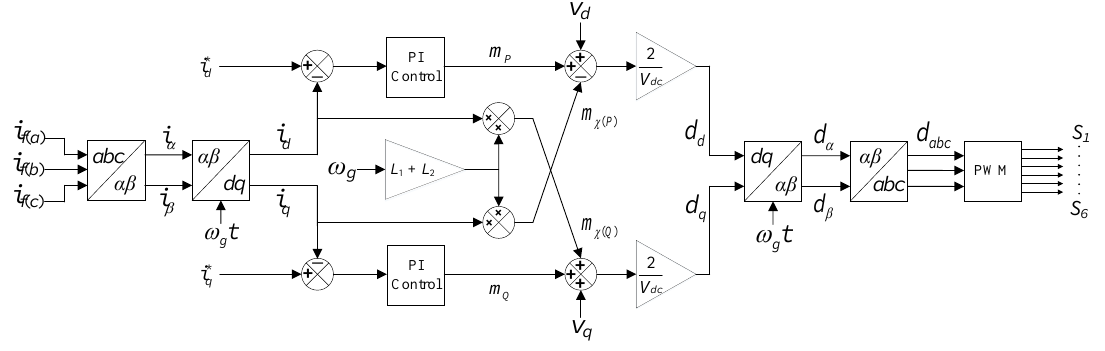
Figure 9. Four-quadrant converter control strategy block